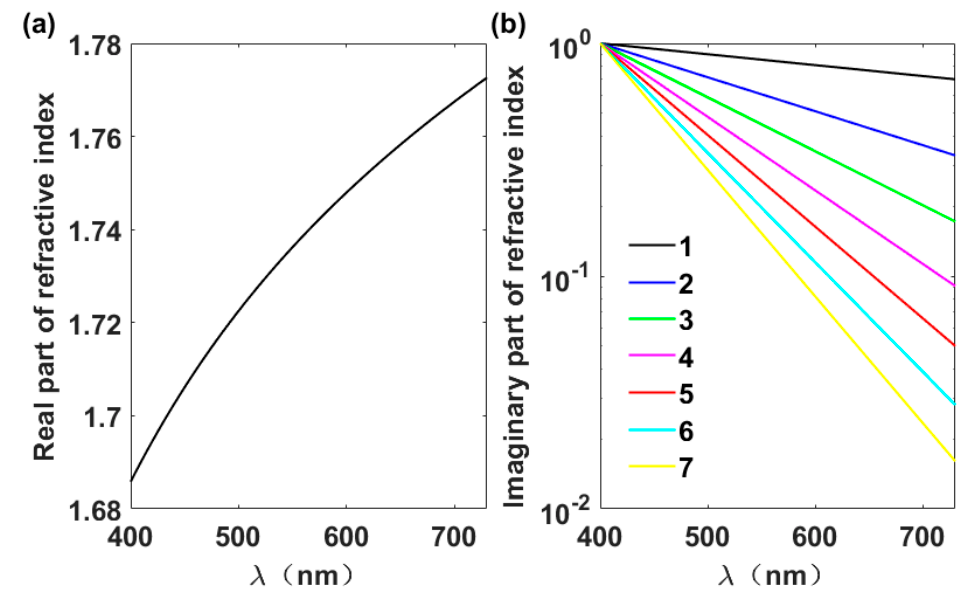
Figure 5. Seven series of hypothetical refractive indices. ( a ) The real part of the refractive index. ( b ) The imaginary part of the refractive index, which is set to be a linear change in logarithmic coordinates.